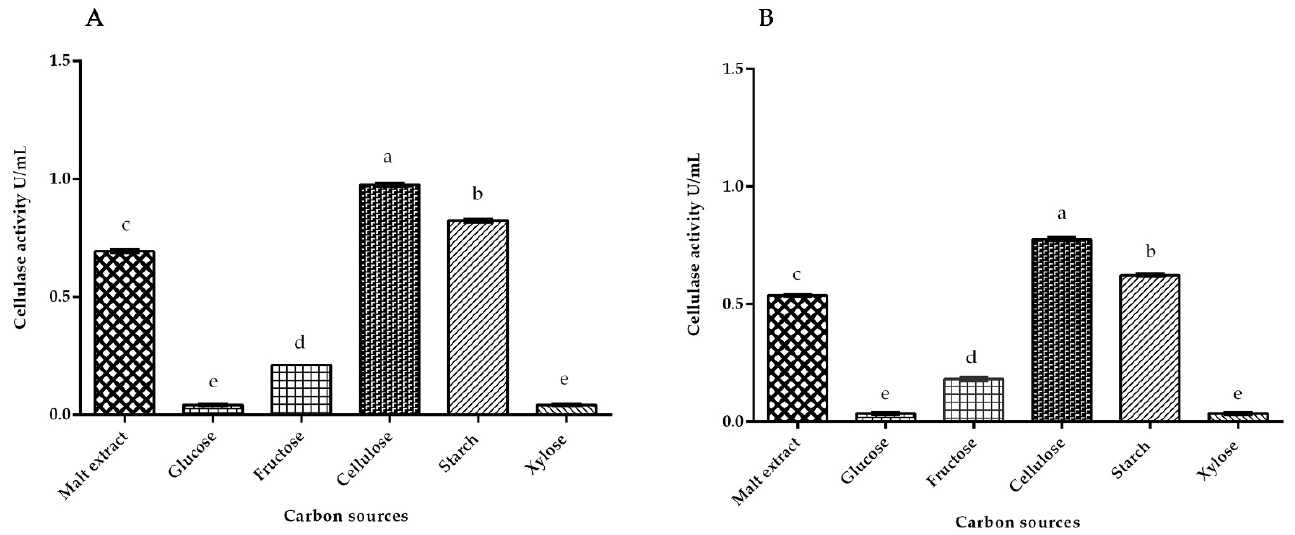
Figure 2. ( A ) Cellulase activity of white rot fungus P . ostreatus under submerged fermentation on different carbon inducers. Bars with different letters (a–e) are significantly different at p < 0.05. ( B ) Cellulase activity of white rot fungus P . chrysosporium under submerged fermentation on different carbon inducers. Bars with different letters (a–e) are significantly different at p < 0.05.